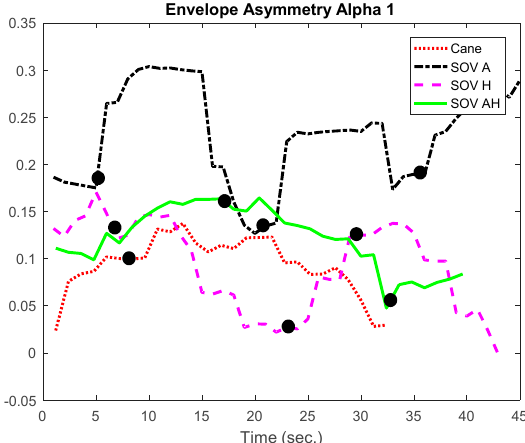
Figure 18. The envelopes of the alpha1 asymmetries for a user who was born blind.